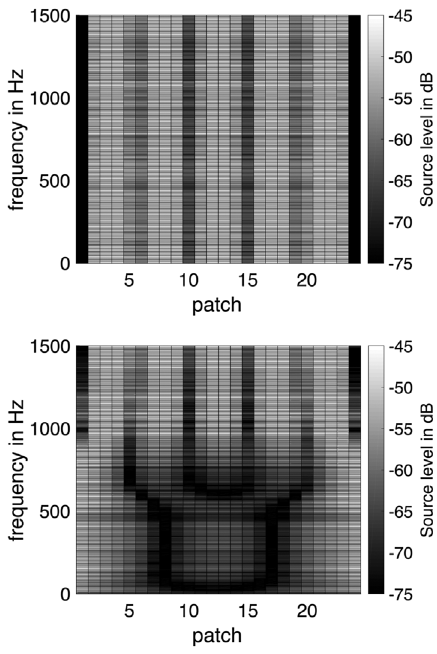
Figure 14. Comparison of the original source distribution along the 24 patches (upper) and the reconstructed source distribution (lower) as function of frequency for N p = 3. Reconstruction based on far- fi eld receiving positions.